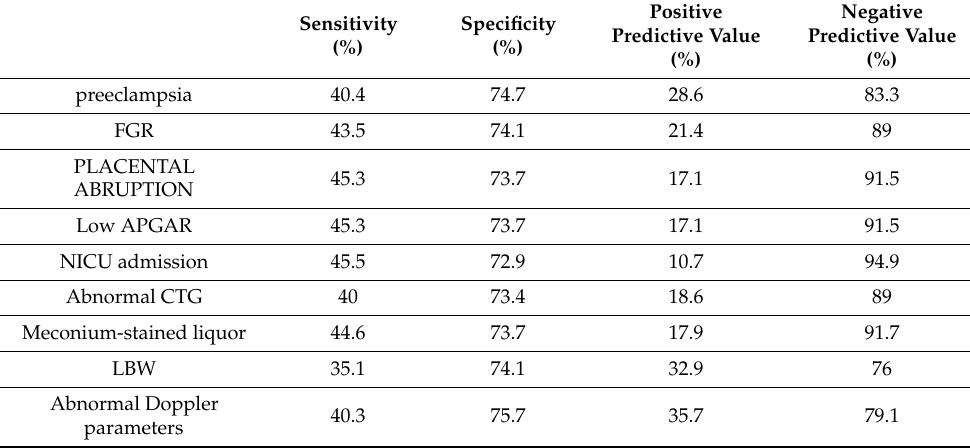
Table 6. Performance of premature placental